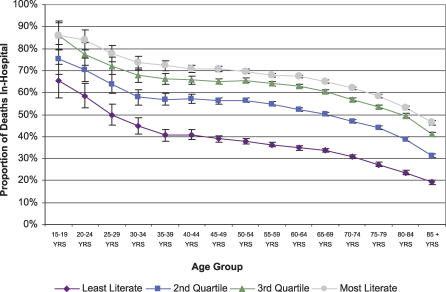
Proportion of Diabetes Deaths That Were in Hospitals, versus Age Group, According to Community Literacy Quartiles, Mexico 1998–2005Data are means and 95% confidence intervals.